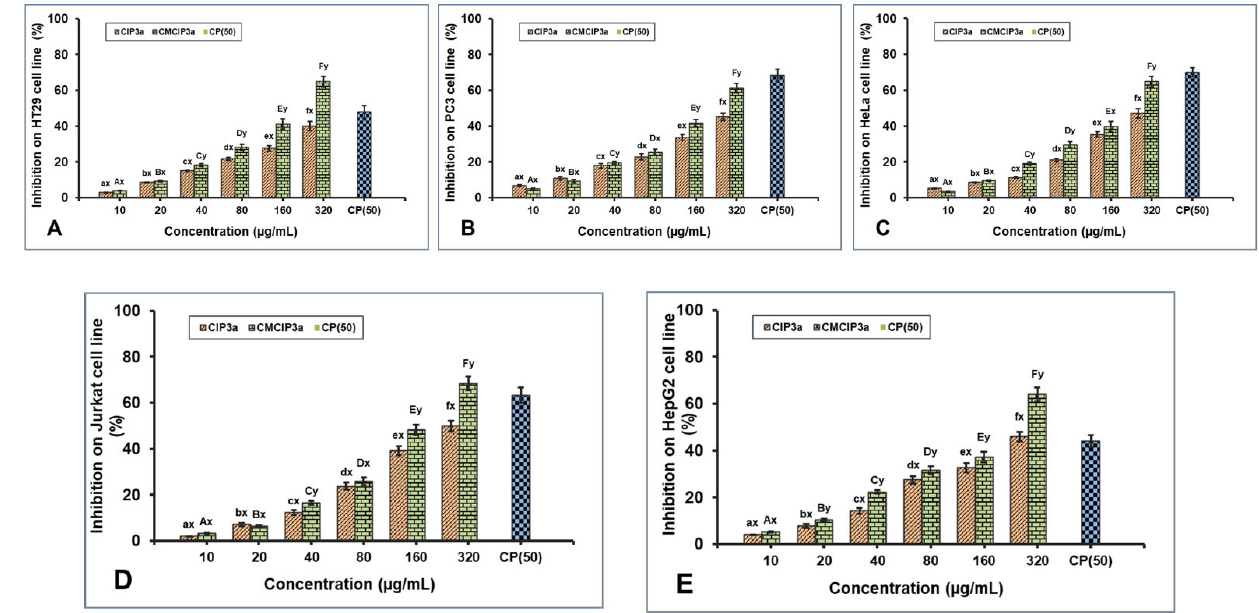
Figure 8. Antiproliferative effects of CIP3a and CMCIP3a on: ( A ) HT29, ( B ) PC3, ( C ) HeLa, ( D ) Jurkat and ( E ) HepG2 cells. Statistically significant ( p < 0.05) increase in CIP3a and CMCIP3a concentrations are denoted by small (a–f) and capital letters (A–F), respectively. Significant ( p < 0.05) differences between samples with same concentrations and different ones are denoted by small letters (x,